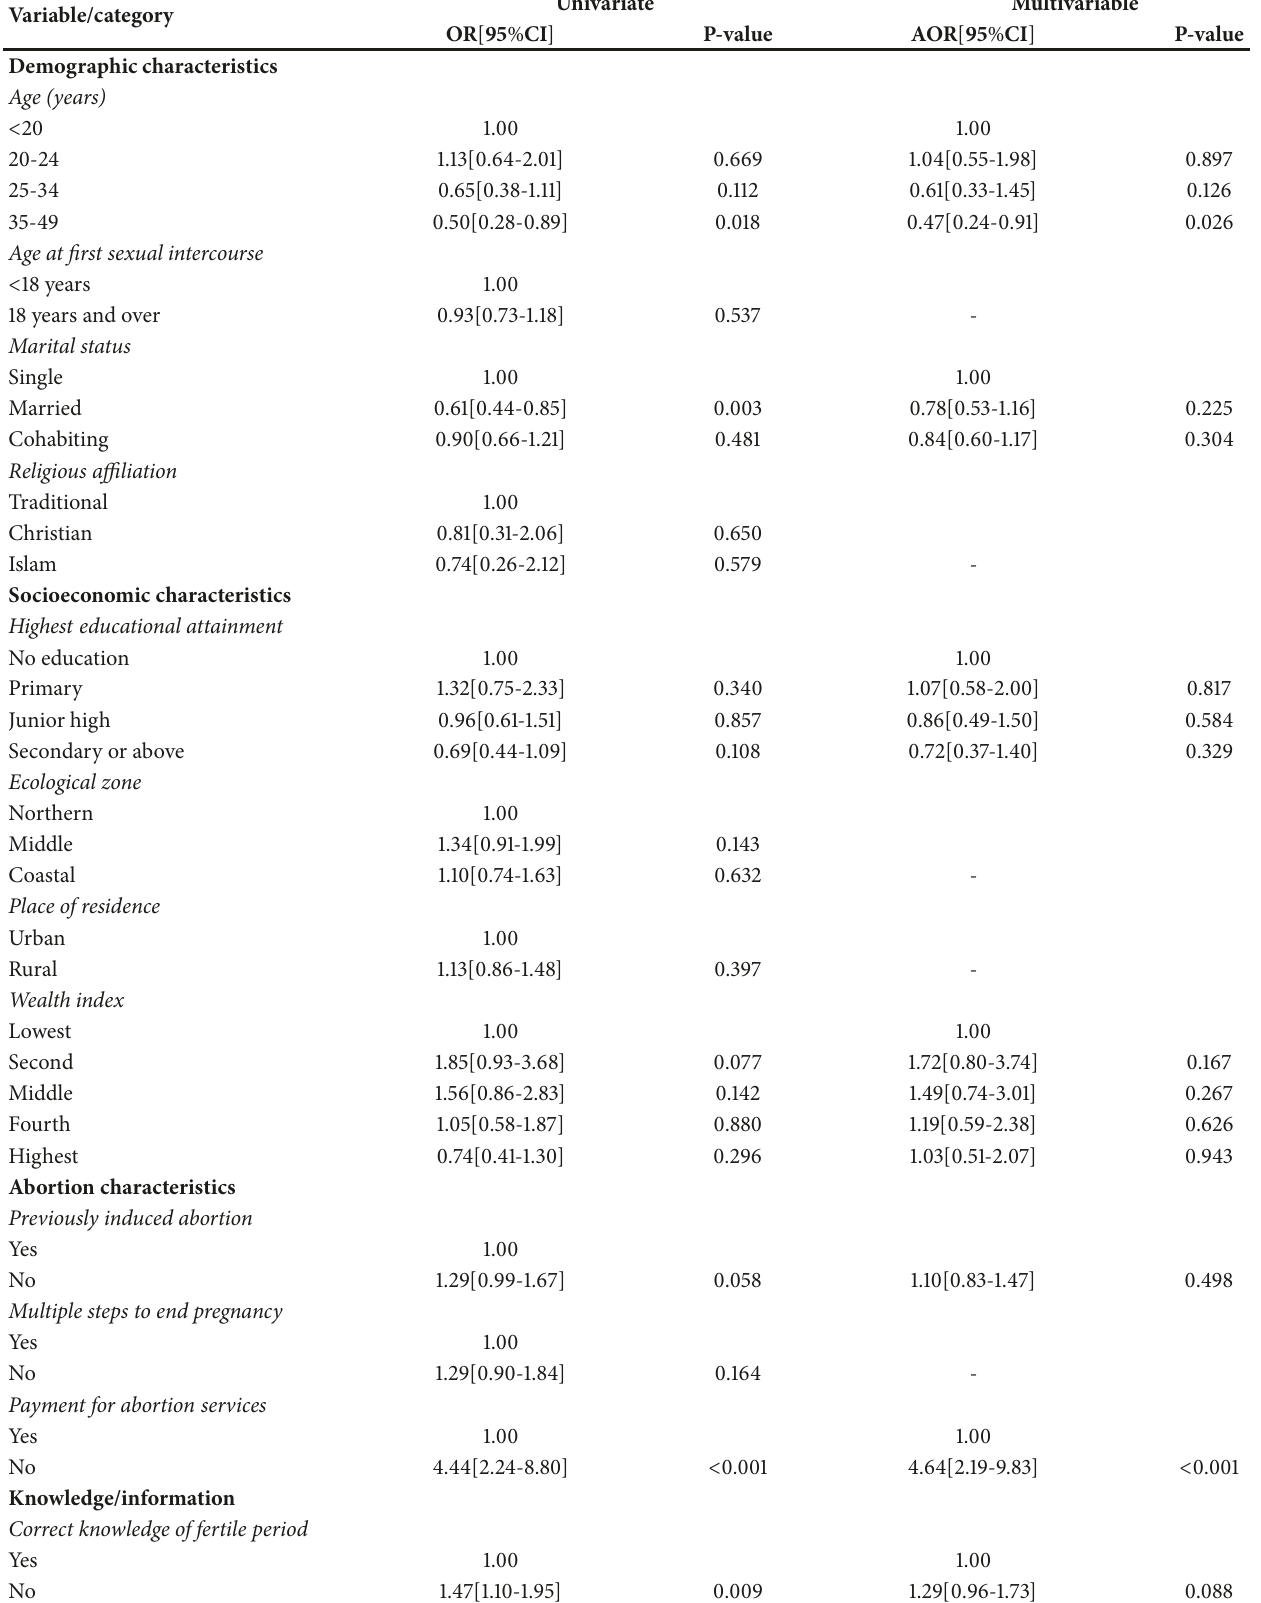
Table 3: Univariate and multivariable logistic regression of the predictors of unsafe induced abortion among women (15-49 years of age) in